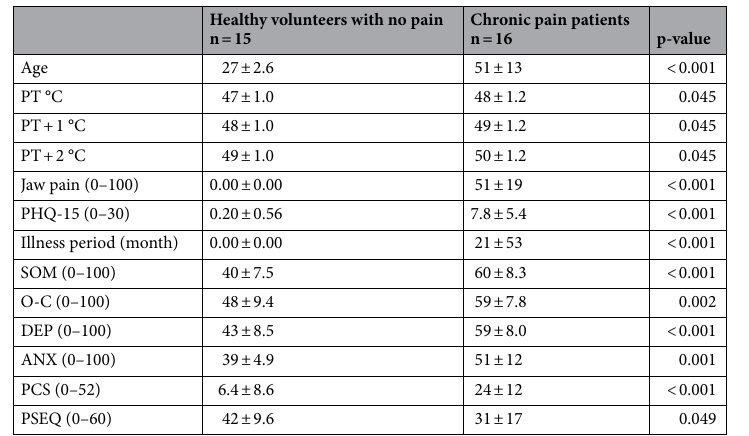
Table 2. Descriptive data of participants. Data are reported as mean ± standard deviation (S.D.). PHQ-15 patient health questionnaire-15, SOM somatization, O–C obsessive–compulsive, DEP depression, ANX anxiety, PCS pain catastrophizing scale, PSEQ pain self-efficacy